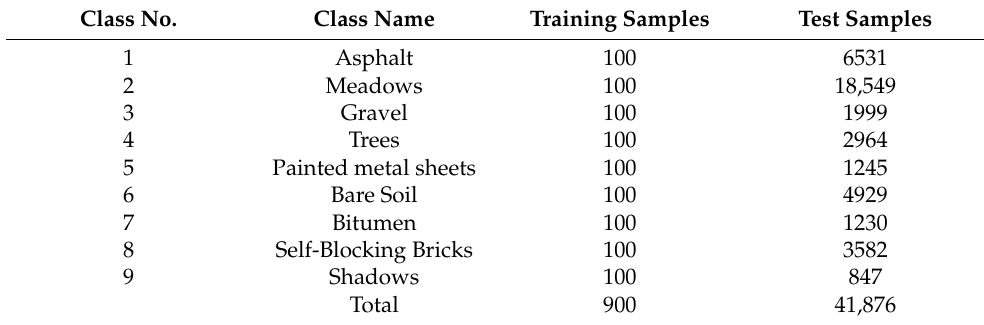
Table 3. The number of training and test samples used in the Pavia University dataset. Class No.